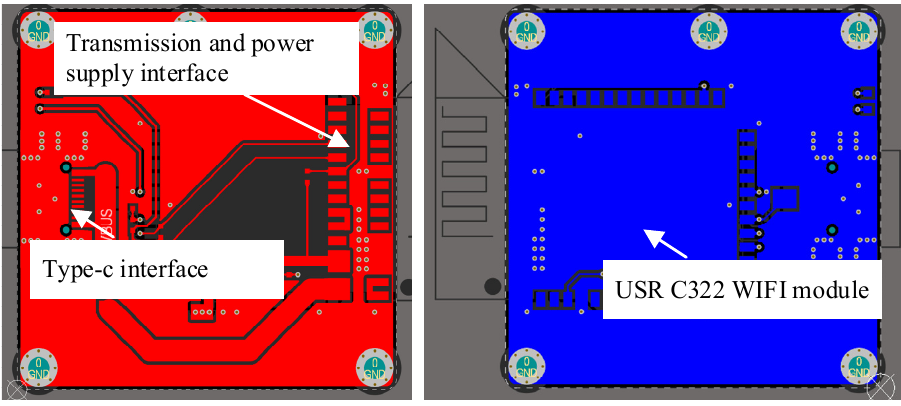
Figure 8. WiFi radar interface circuit. Figure 7 is the schematic diagram of the circuit, the WIFI circuit board and the radar board were connected by connecting pins, on which power supply and UART serial port transmission were integrated.